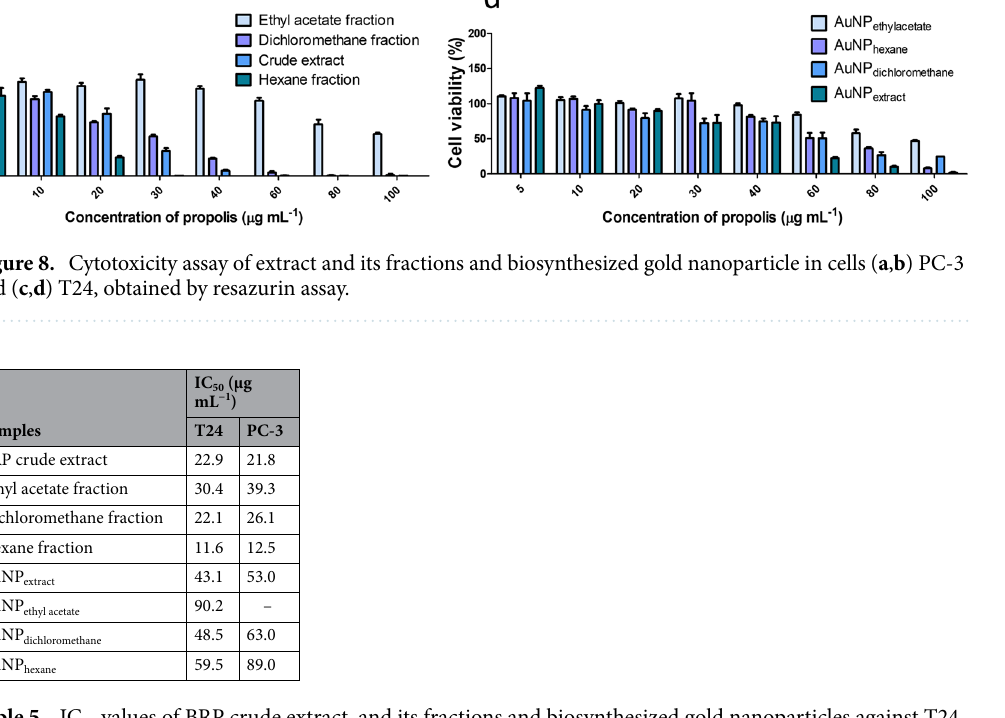
Table 5. IC 50 values of BRP crude extract, and its fractions and biosynthesized gold nanoparticles against T24 and PC-3 cancer cell lines.